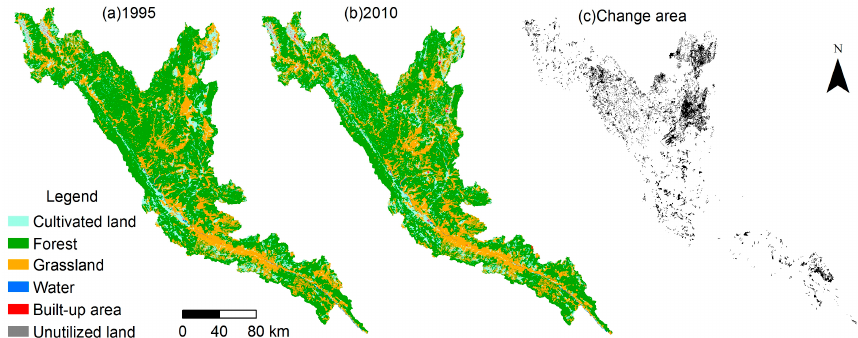
Figure 2. Land use maps in 1995 ( a ); 2010 ( b ); and change area ( c ) in the URRB.